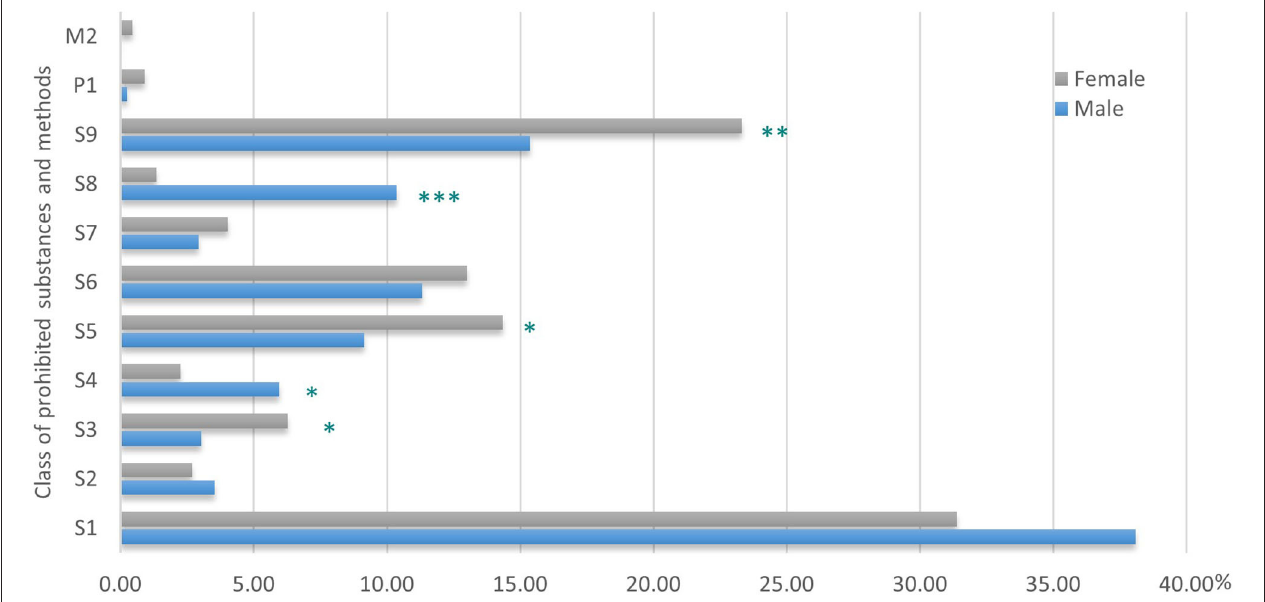
FIGURE 1 | Distribution of classes of prohibited substances and methods (in %) in female and male athletes. *** p < 0.001; ** p < 0.01; * p < 0.05, gender difference in distribution of class of substances and